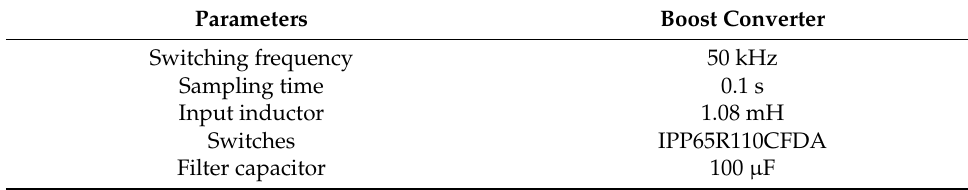
Figure 7. Block diagram of the proposed MPPT system. Table 1. Parameters of the utilized boost converter.